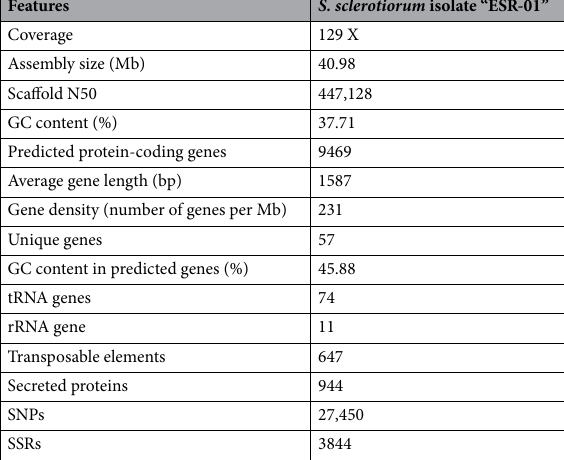
Table 1. Assembly and gene statistics features of Sclerotinia sclerotiorum isolate ‘ESR-01’.